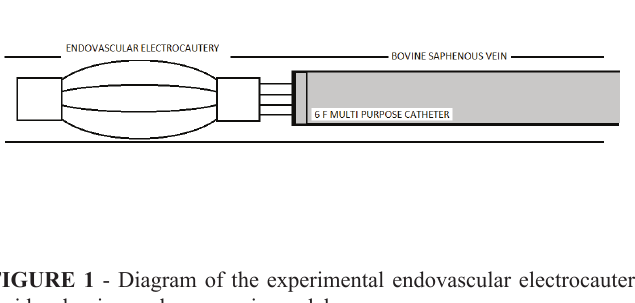
FIGuRE 1 - Diagram of the experimental endovascular electrocautery inside a bovine saphenous vein model.